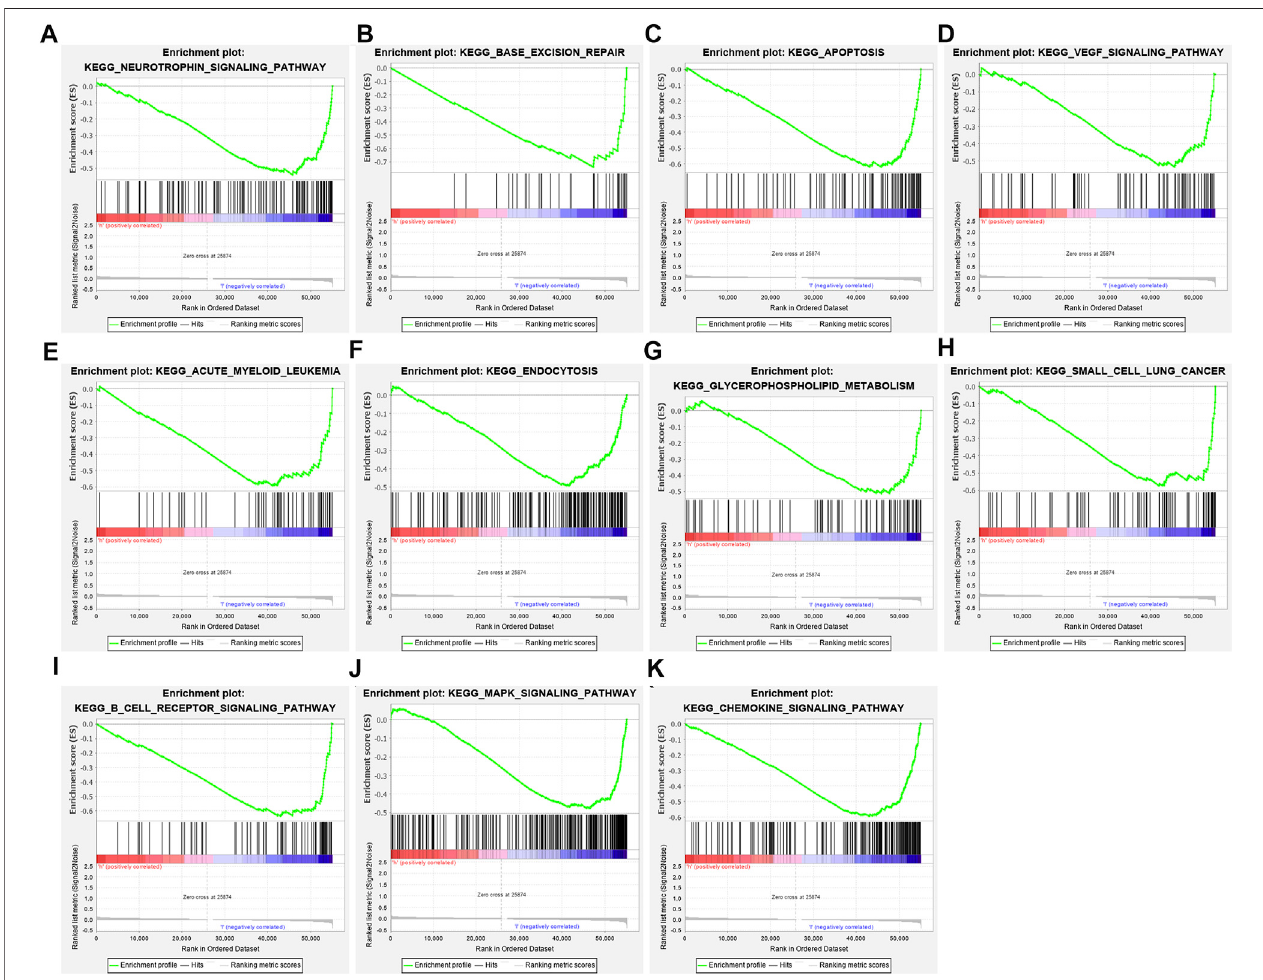
FIGURE 5 | Gene Set Enrichment Analysis (GSEA) identi fi es signaling pathways underlying the TSG-based prognostic classi fi er. (A) Neurotrophin signaling pathway, (B) base excision repair, (C) apoptosis, (D) VEGF signaling pathway, (E) acute myeloid leukemia, (F) endocytosis, (G) glycerophospholipid metabolism, (H) small cell lung cancer, (I) B-cell receptor signaling pathway, (J) MAPK signaling pathway, and (K) chemokine signaling